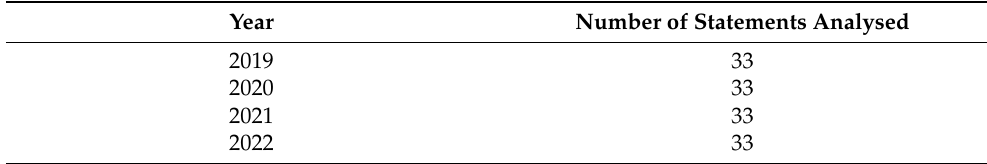
Table 4. Number of analysed student responses per